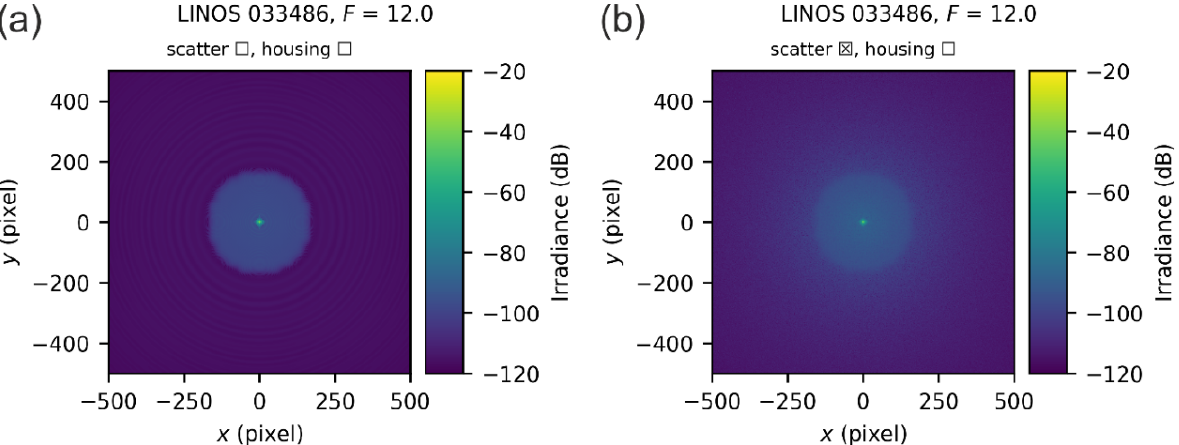
Figure 9. Simulated irradiance distribution at the focal plane of the LINOS 033486 lens for an f-number of F = 12: ( a ) simulation neglecting light scattering and ( b ) simulation, which takes light scattering at the surfaces of the optical elements into account. As simulation parameters, set 1 of the simulation settings was applied.